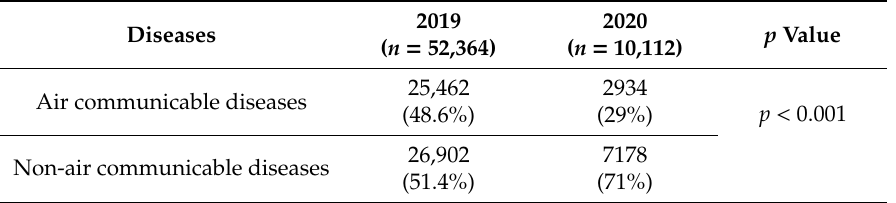
Table 2. Air communicable vs. non-air communicable